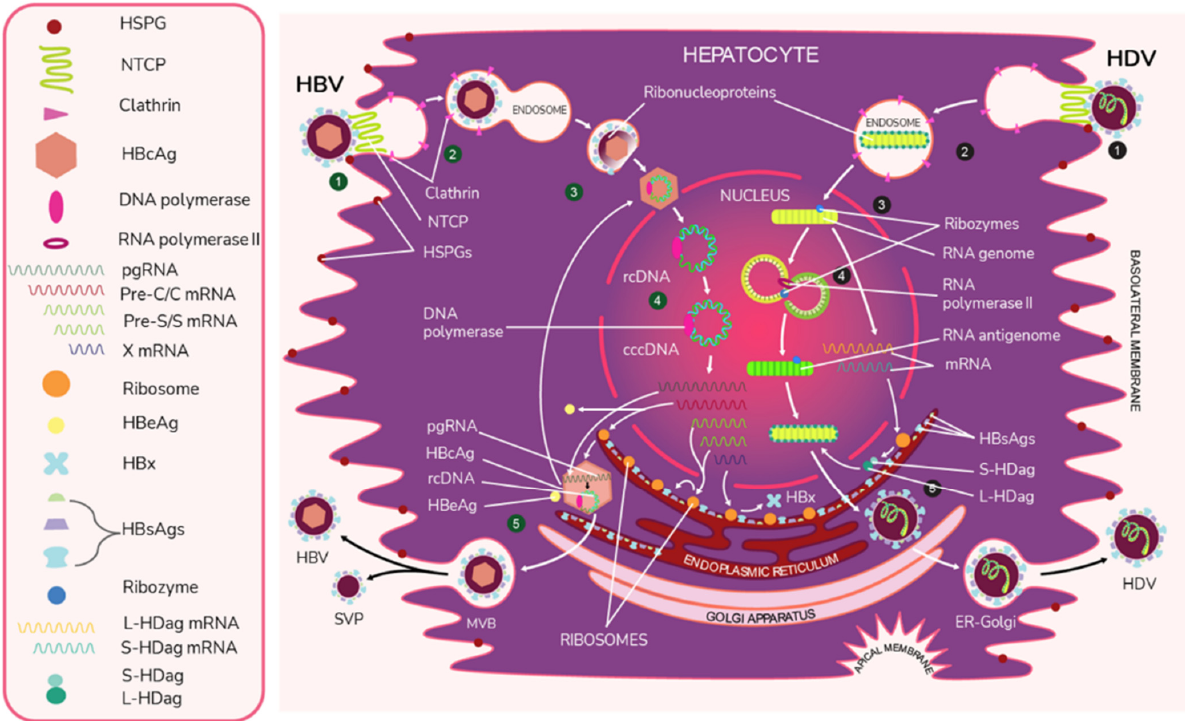
Figure 2. The viral life cycles of HBV and HDV. HBV (green numbers): (1) HBV attaches to the hepatocyte by first binding to host heparan sulfate proteoglycans (HSPGs) and then binding to the liver cell entry receptor sodium taurocholate cotransporting polypeptide (NTCP) with the pre-S1 domain of L-HBsAg. (2) HBV enters the cell via the clathrin-mediated endocytosis pathway through clathrin protein interactions with L-HbsAg on the HBV membrane. (3) The viral envelope fuses to the early endosome, and the core protein of the exposed nucleocapsid binds to the host nucleus and releases its viral DNA and DNA polymerase. * (4) The virus begins replication by first completing its partially double-stranded relaxed circular (rcDNA) using DNA polymerase to create full dsDNA in the form of covalently closed circular DNA (cccDNA). The DNA is then transcribed by host RNA polymerase II into pregenomic RNA (pgRNA) and 4 mRNAs. The 4 mRNAs are translated by host ribozymes. The “Pre-C/C” mRNA is translated into HBcAg core and HBeAg, the “Pre-S” and “S” mRNAs into HBV surface proteins, and “X” mRNA into HBx protein, which is involved in infection and replication. The pgRNA is transported to the cytoplasm, where it is encapsidated by the HBcAg core. Inside this preliminary nucleocapsid, HBV polymerase reverse transcribes pgRNA into negative-sense DNA, which undergoes synthesis into partially double-stranded rcDNA. The completed nucleocapsid either travels back to the nucleus to create additional virions or buds from the ER membrane, acquiring an envelope that is embedded with HBsAg. (5) Along with the infectious virions, empty subviral particles (SVPs) also bud out from the ER. The exiting viral and subviral particles pass through the Golgi apparatus into multivesicular bodies (MVBs), which then bind to the hepatocyte envelope and are released via exocytosis. HDV (black numbers): (1) HDV attaches to the host cell through low-specificity binding to HSPGs and high-specificity binding to NTCP with the viral L-HBsAg pre-S1 domain. (2) The virus enters the cell. (3) The viral envelope is uncoated and the ribonucleoprotein targets the hepatocyte nucleus. * (4) In a rolling circle manner, the viral RNA genome is transcribed into the antigenome, and the antigenome serves as a template for new genome transcripts, both of which self-cleave and ligate to reform the circular RNA. The genome also produces S-HDAg and L-HDAg mRNA from the same open reading frame. This process produces approximately 300,000 genome and a smaller number of antigenome molecules. (5) The translated protein products re-enter the nucleus to complete replication and particle assembly. Fully assembled HDV virions pass through the ER-Golgi complex and exit the host cell. * The exact uncoating mechanisms of the envelope and nucleocapsid are not fully